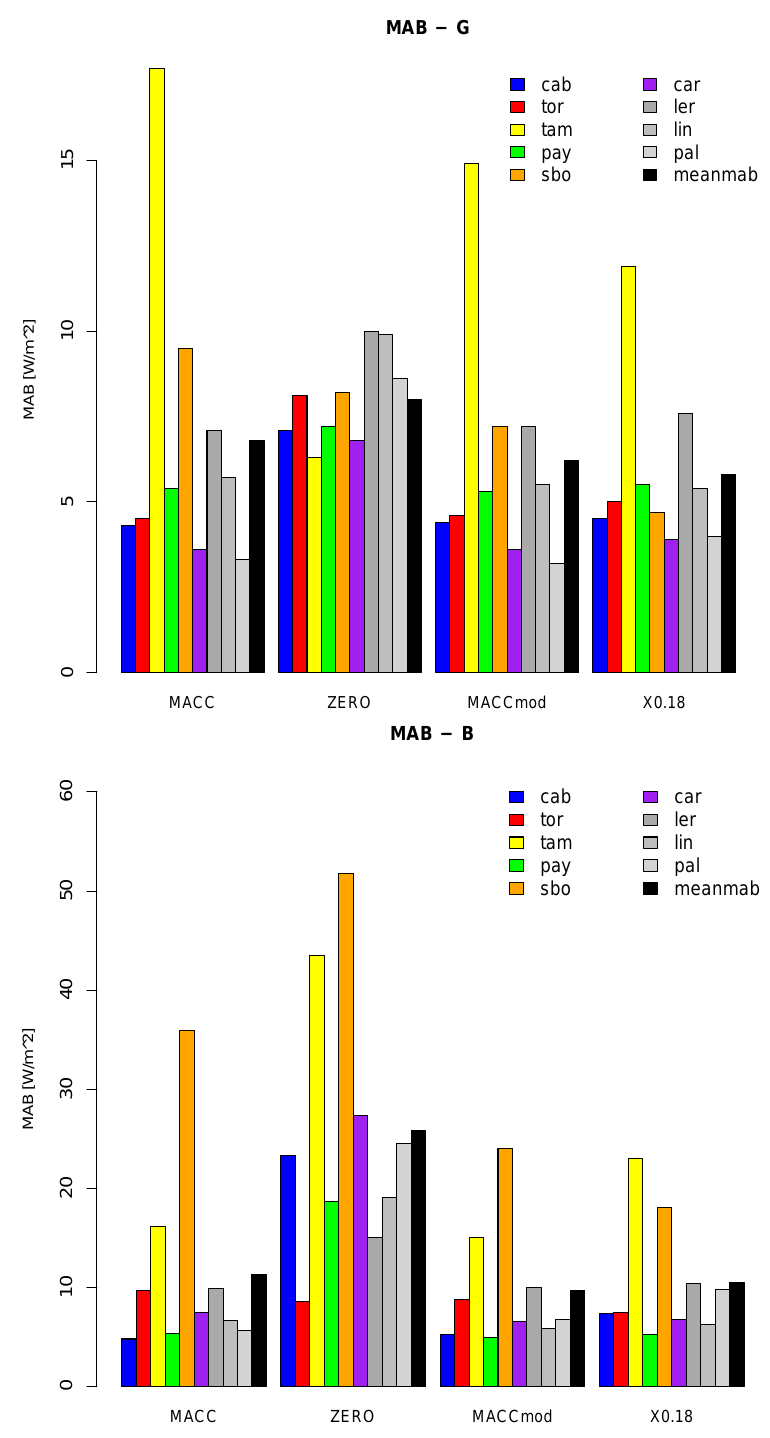
Figure 5. Mean Absolute Bias of the global irradiance (MAB-G, top ) and the direct irradiance (MAB-B, bottom ) for MACC, MACCmod and the zero and 0.18 AOD assumptions, evaluated at nine different Baseline Surface Radiation Network (BSRN) stations (colored bars). “meanmab” is the mean MAB over all nine stations. The effect of aerosols on direct irradiance is much more pronounced. As a result much higher errors are apparent for direct irradiance than for global